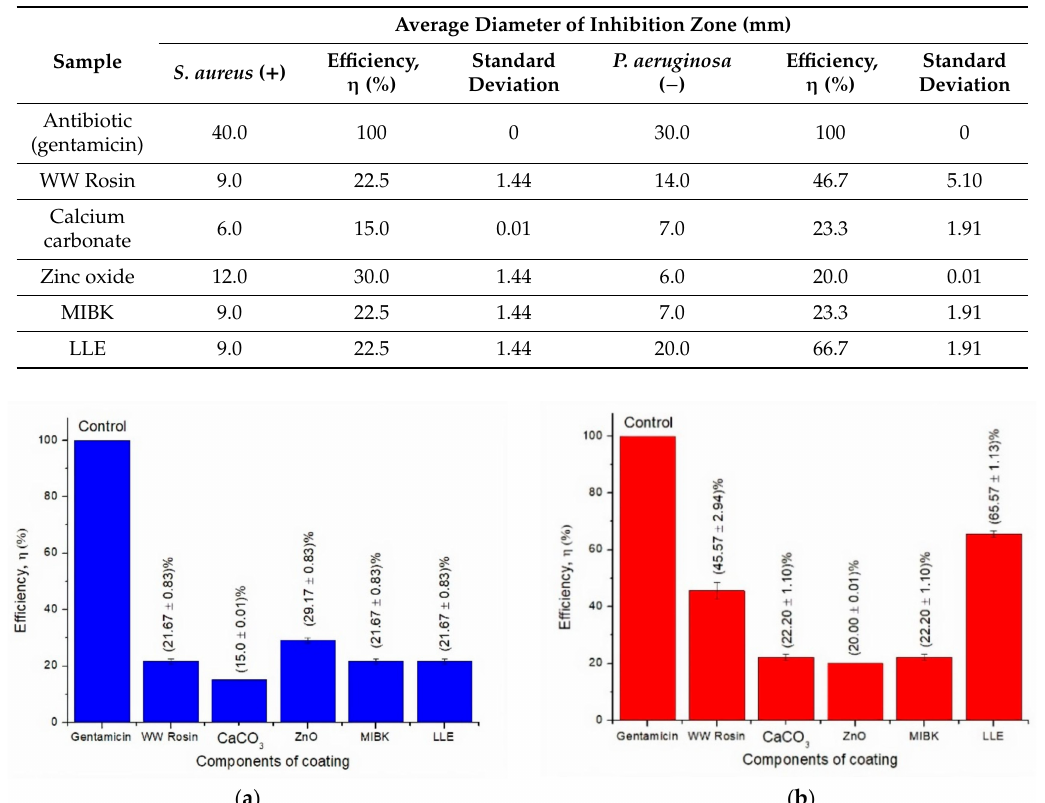
Table 5. Inhibition zone for the coating components.